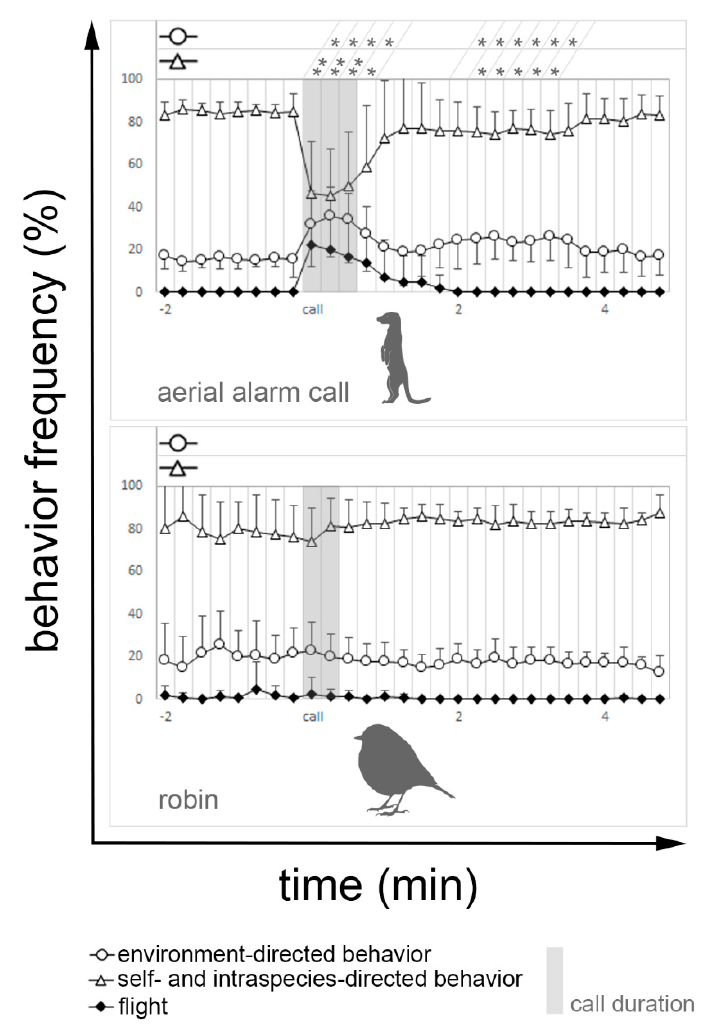
Figure 3. The figure shows how the self- and intraspecies-directed, the environment-directed, and the flight behavior evolve for the playback of the aerial alarm call and the control stimuli (robin). The time axis is divided into 15 s intervals. Each interval shows how frequent the associated behavior was observed (in %). The gray shaded area marks the period in which the stimulus was presented. If present, a significant difference between one interval and the mean of the eight intervals before stimulus onset for self- and intraspecies-directed behavior and environment-directed behavior can be taken from the top of each diagram. Only significant differences are shown: (*) p ≤ 0.05; (**) p ≤ 0.01.